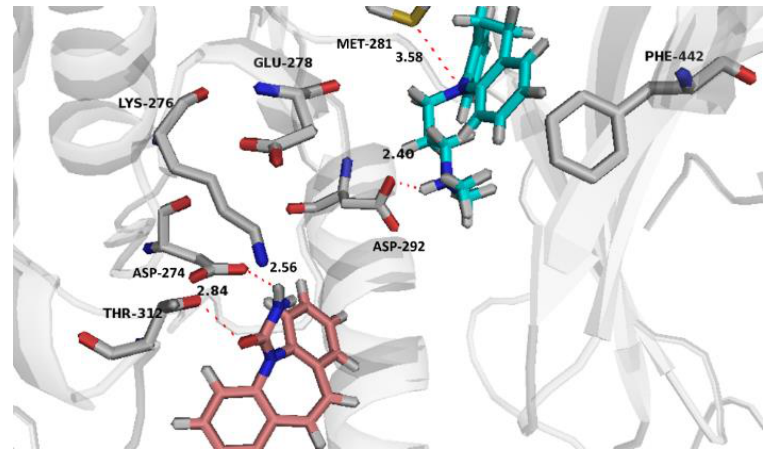
Figure 10. Binding interactions of co-bound CBZ (carbons in brown) and IMI (carbons in light blue) with the Akt (PDB Code: 4GV1) allosteric site and active site, respectively. Distances are represented as red dotted lines and are measured in Angstrom (Å ).